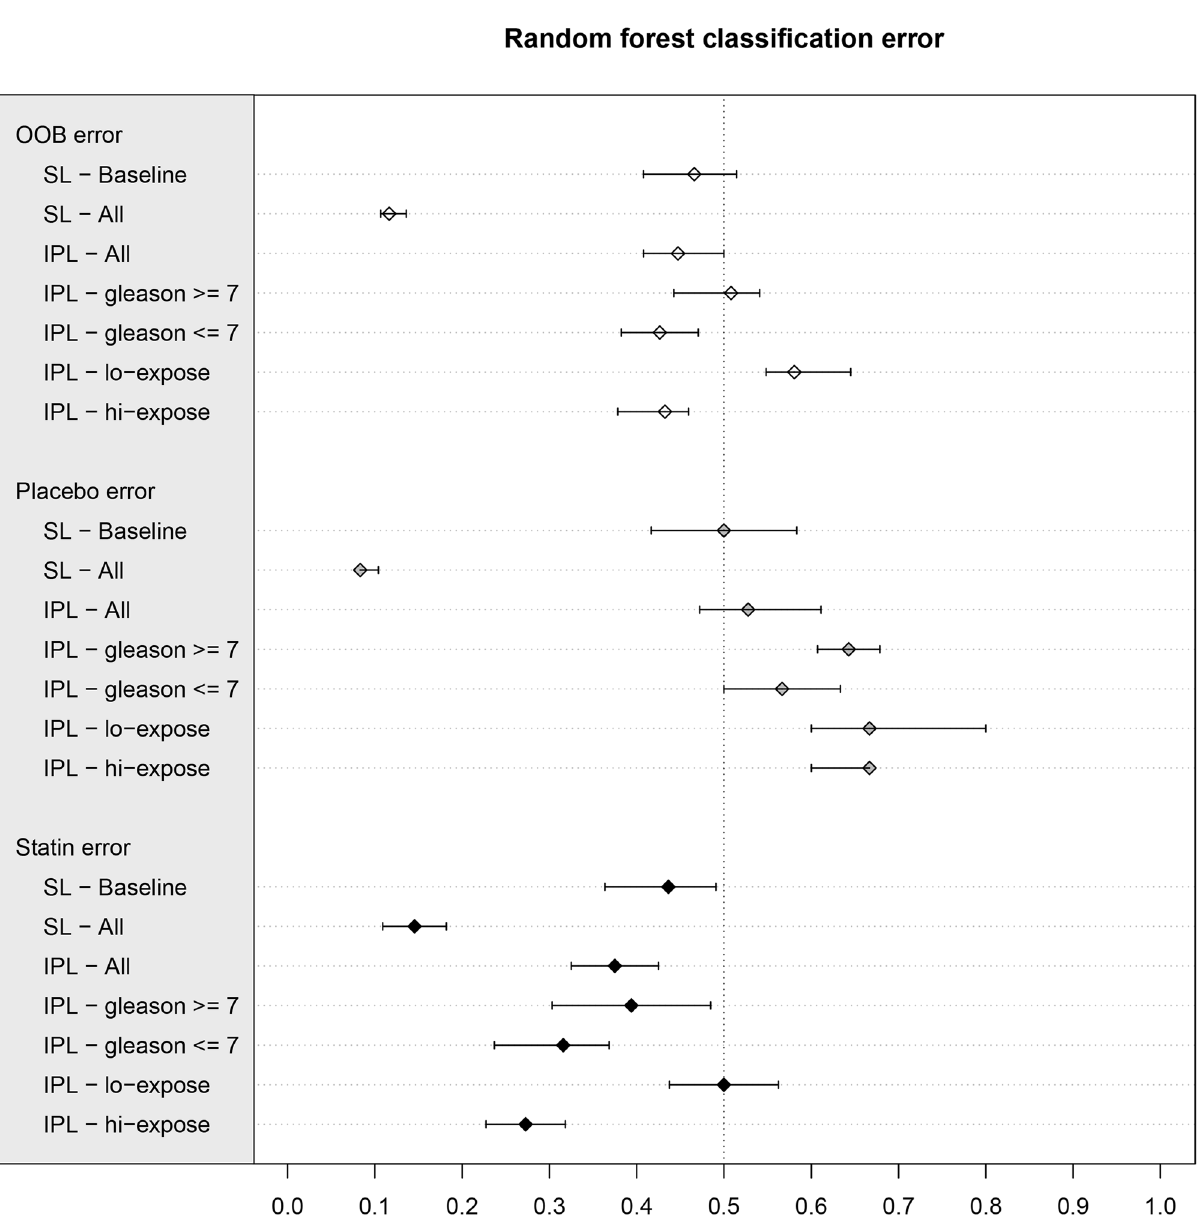
sub-populations is small, compared to the corresponding difference between high- and low-exposed groups. The result suggests that PrCa aggressiveness does not significantly, if at all, modify the association between statin use